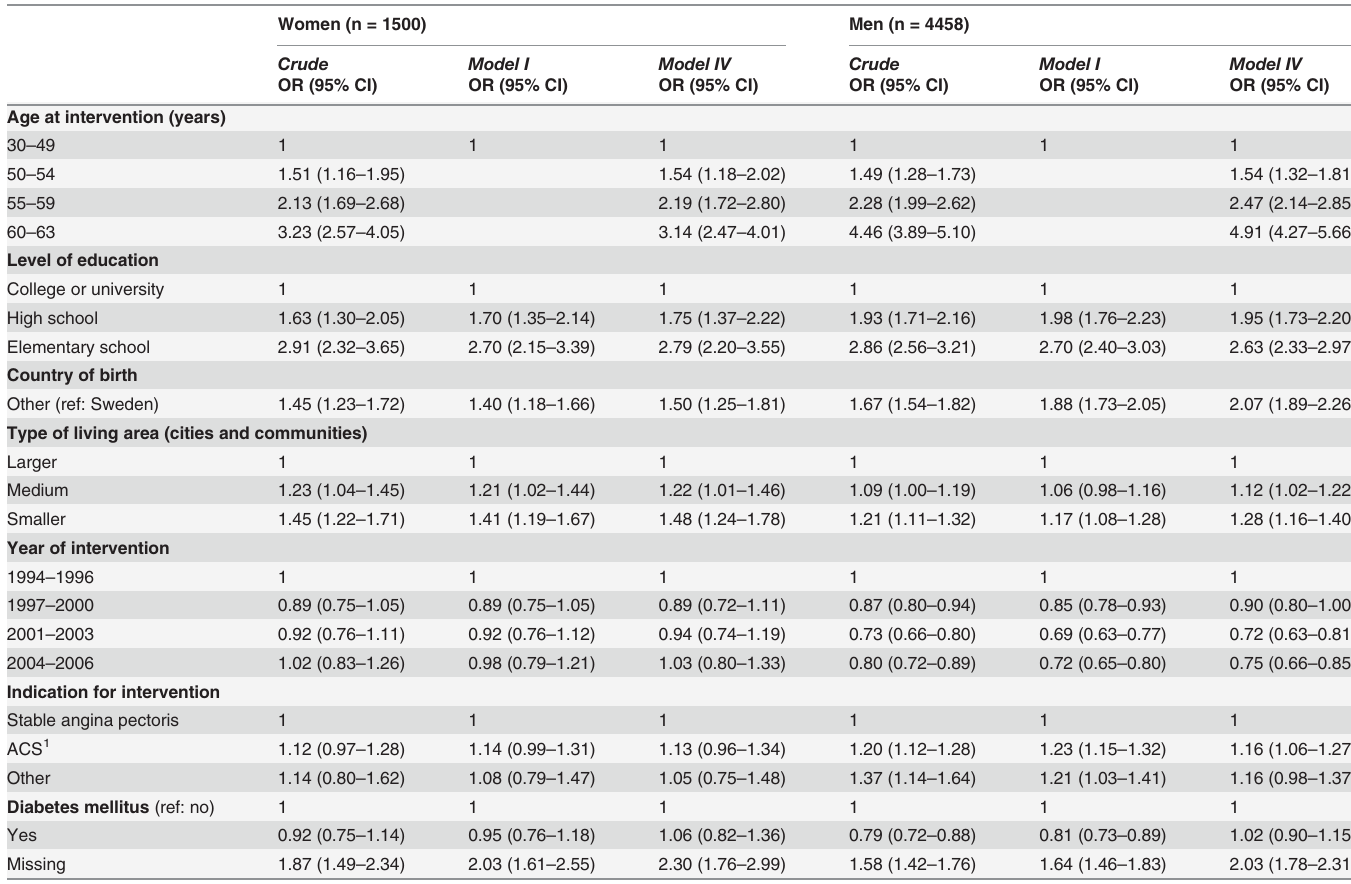
Table 4. Crude and adjusted odds ratio (OR) with 95% con fi dence interval (CI) for disability pension (DP) at time of a fi rst coronary artery bypass graft surgery (CABG), among women and men, with regard to sociodemographic and medical